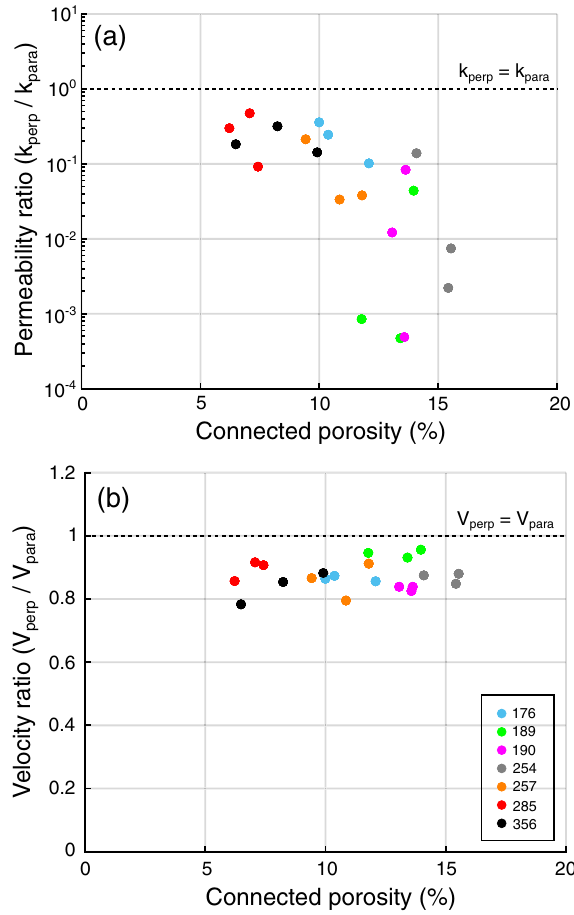
Fig. 10 a Permeability ratio and b P-wave velocity ratio as a function of connected porosity for the Buntsandstein sandstone samples prepared for this study. The number refers to the box